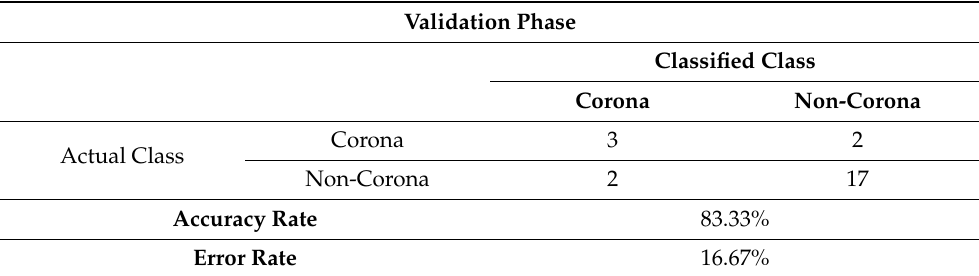
Table 12. Confusion matrix for validation phase—frequency domain corona fault classification.